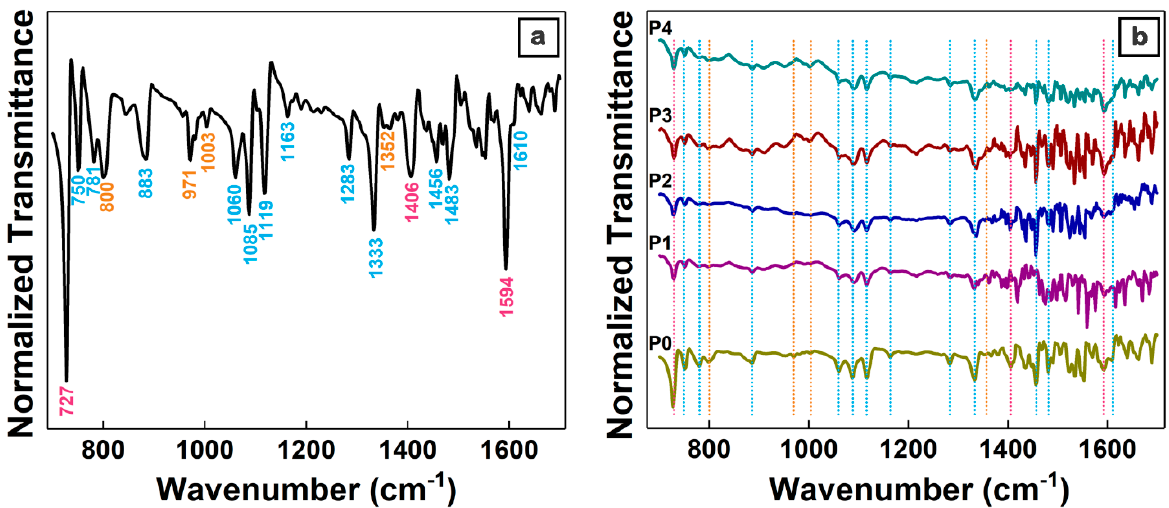
Figure 3. FTIR spectra of the reference film prepared by drop-casting from P0 solution ( a ) and P0– P4 films deposited by MAPLE ( b ) on silicon. Color legend of peaks and lines: magenta—both organic components, ZnPc and TPyP; blue—ZnPc; orange—TPyP.